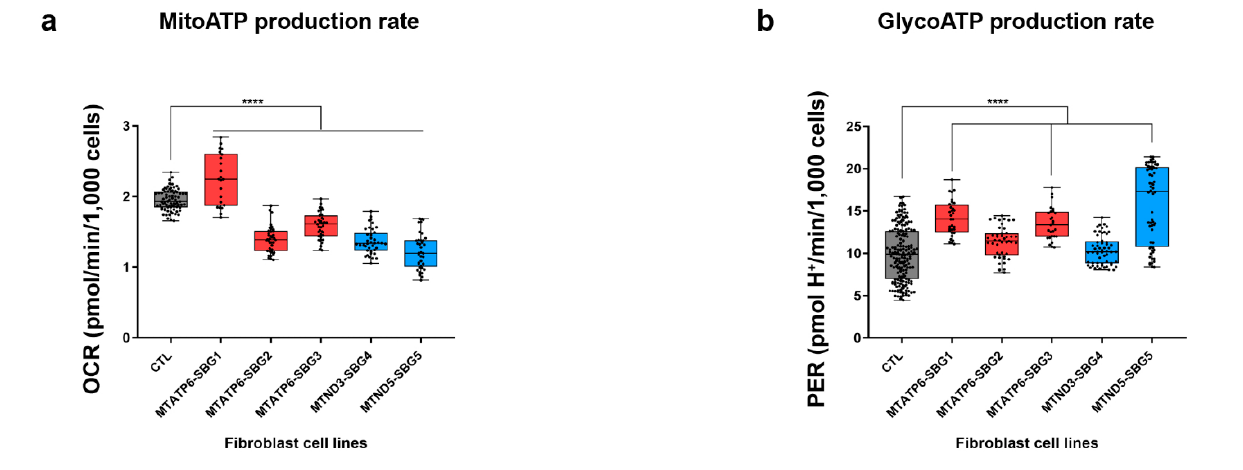
Figure 3. Production of ATP in BJ-FB and five LS fibroblast cell lines. The LS lines are SBG1-FB ( MT-ATP6-T8993G ), SBG2-FB ( MT-ATP6-T8993G ), SBG3-FB ( MT-ATP6-T9185C ), SBG4-FB ( MT-ND3-T10158C ), and SBG5-FB ( MT-ND5-T12706C ), impacting the function of ATP synthase or NADH dehydrogenase. ( a ) Mitochondrial ATP rate and ( b ) Glyco-ATP rate. Data are shown in pmol H +/min/1000 cells as mean +/ − SD. Experiments were repeated at least three times on different days under the same conditions. **** p < 0.0001. Comparative analyses for all diseased (SBG1-5) FBs were conducted with the healthy control BJ-FB line. OCR: oxygen consumption rate. PER: proton efflux rate.